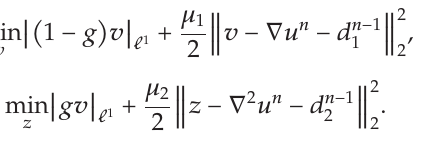
Algorithm 4.4 (cid:3) PPM to solve (cid:3) 1.7 (cid:4)(cid:4) . (cid:3) 1 (cid:4) Choose the original d 0